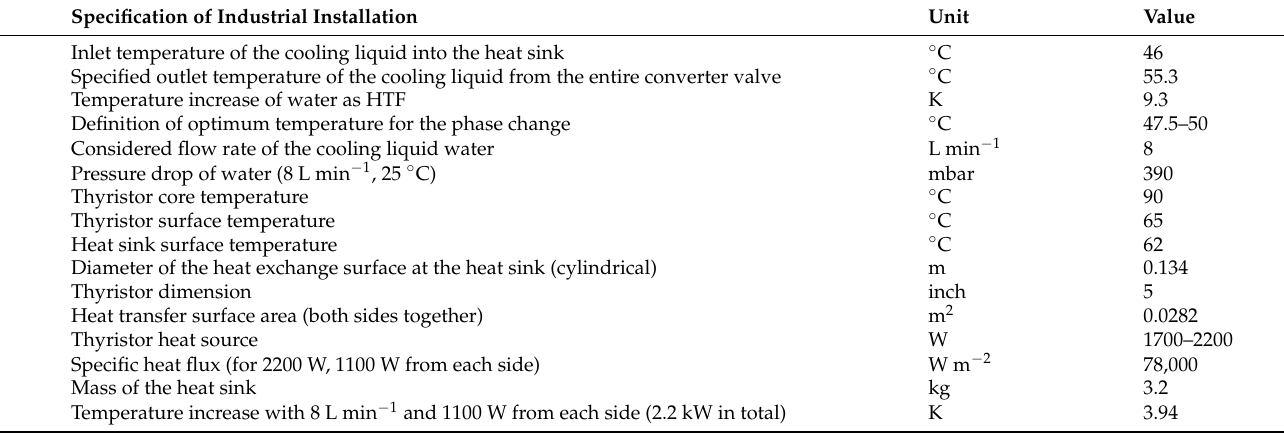
Figure 1. Schematic of a typical thyristor and heat sink stack. Table 1. Specifications for standard industrial high voltage direct current (HVDC) cooling system requirements.